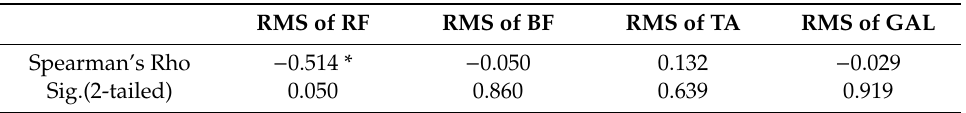
Figure 5. ( a ) shows the trend of RMS (x ± s) on RF, BF, and ( b ) shows the trend of RMS (x ± s) on TA, GAL in the incremental load experiment. Table 5. The correlation between RMS and subjective fatigue RPE of each targeted muscle in the incremental load